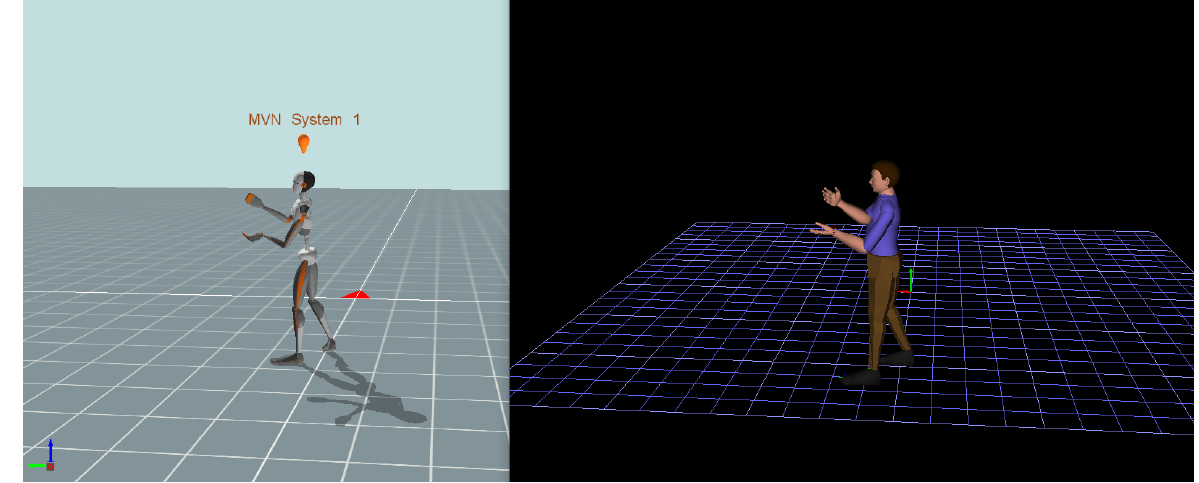
Figure 1. The integration of Xsens motion capture system with JACK ergonomics software. The Xsens model is on the left, which represents the recorded actual human movement, while the JACK model is on the right to represents the human dynamic simulation.